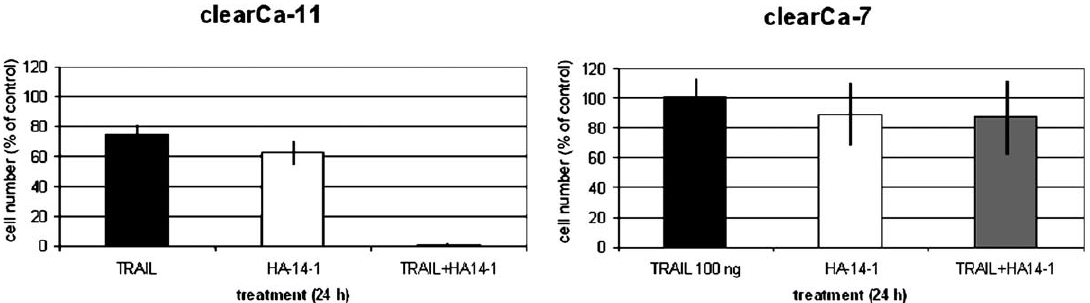
Fig. 6. Effect of combined treatment of TRAIL and HA14-1 on RCC cell number. Synergistic reduction of cell number in the TRAIL-sensitive cell line clearCa-11 after combined exposure to 25 µM HA14-1 and 25 ng TRAIL after 24 h. No effect in the TRAIL-resistant cell line clearCa-7 after combined treatment with HA14-1 (25 µM) and TRAIL (100 ng/ml) after 24 h. (Data represent median ± standard deviation in three independent